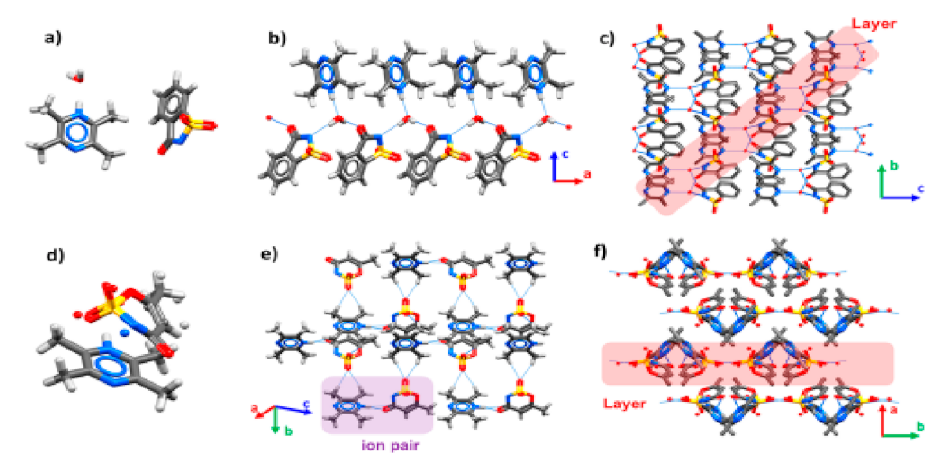
Figure 6. Crystal structures of TMP-SAC ( a – c ) and TMP-ACS ( d – f ). The blue lines represent hydrogen bonds [31] (with permission from [31]; Copyright 2020 American Chemical